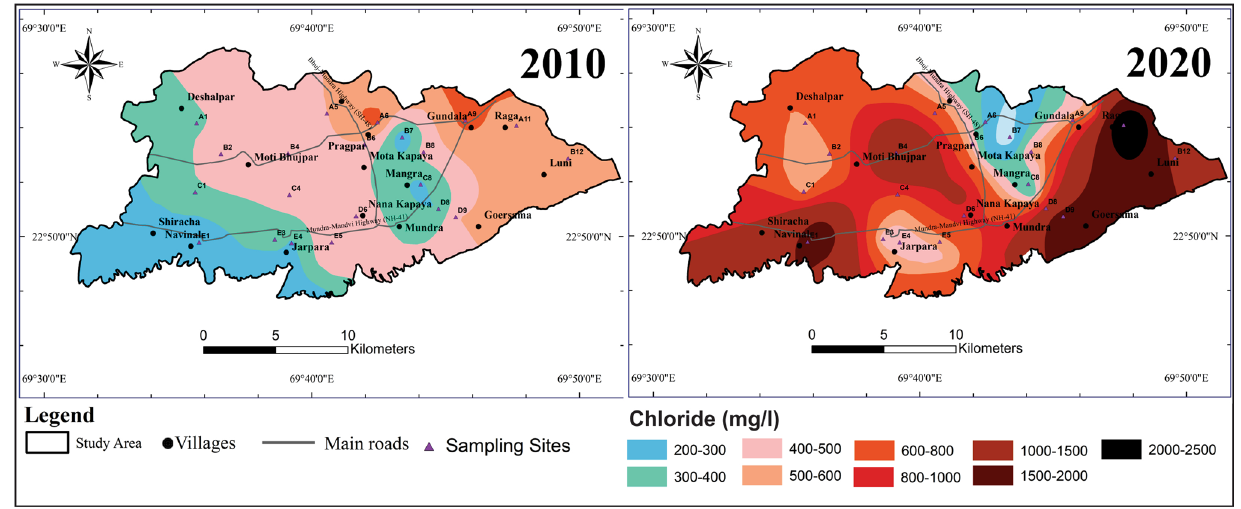
Fig. 3 Geospatial distribution of chloride (Mg/L) of 2010 (Bhimani 2013 and